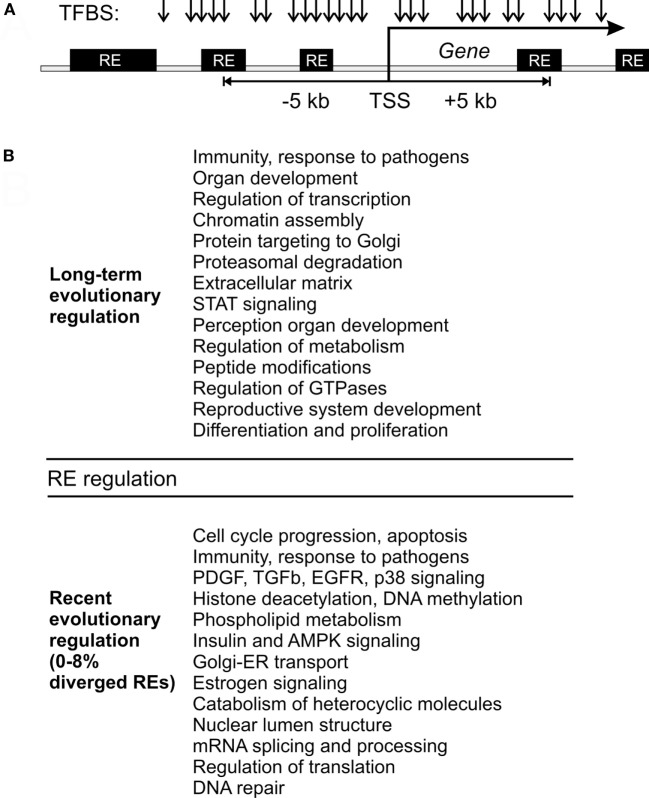
Model of gene expression regulation by RE-linked transcription factor binding site (TFBS). (A) Schematic representation of TFBS (arrows) that may overlap with the REs (black boxes) close to transcription start sites of known human genes (shown as “TSS”). (B) Outline of RE-linked TFBS regulation at the long-term and recent evolutional perspectives. This figure aggregates data for both single gene and molecular pathway analysis.